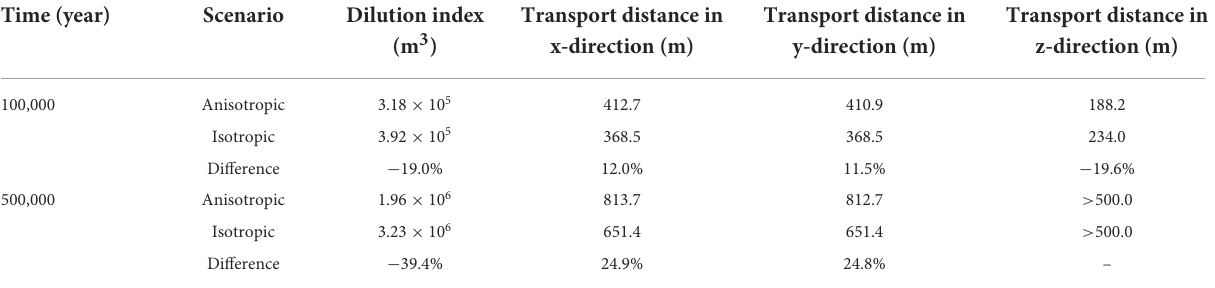
TABLE 6 Dilution index, representing simulated plume volume, and solute transport distances in x-, y- and z-directions for a hypothetical DGR site for anisotropic and equivalent isotropic scenarios. Time